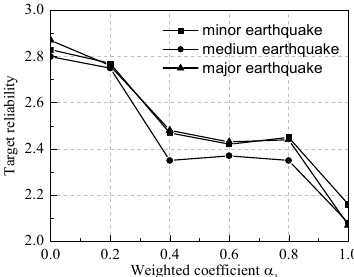
Figure 6. The relationship between reliability and weight coefficient α 1